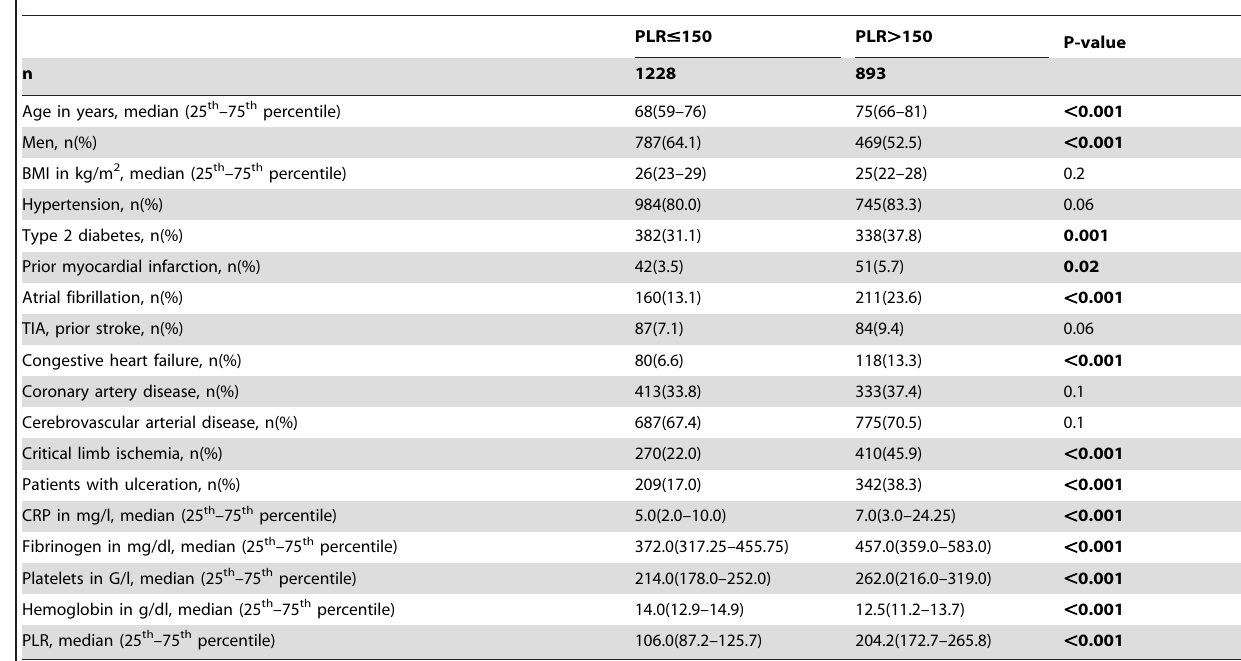
Table 2. Clinical and hematological characteristics of population with PLR # 150 and PLR . 150.